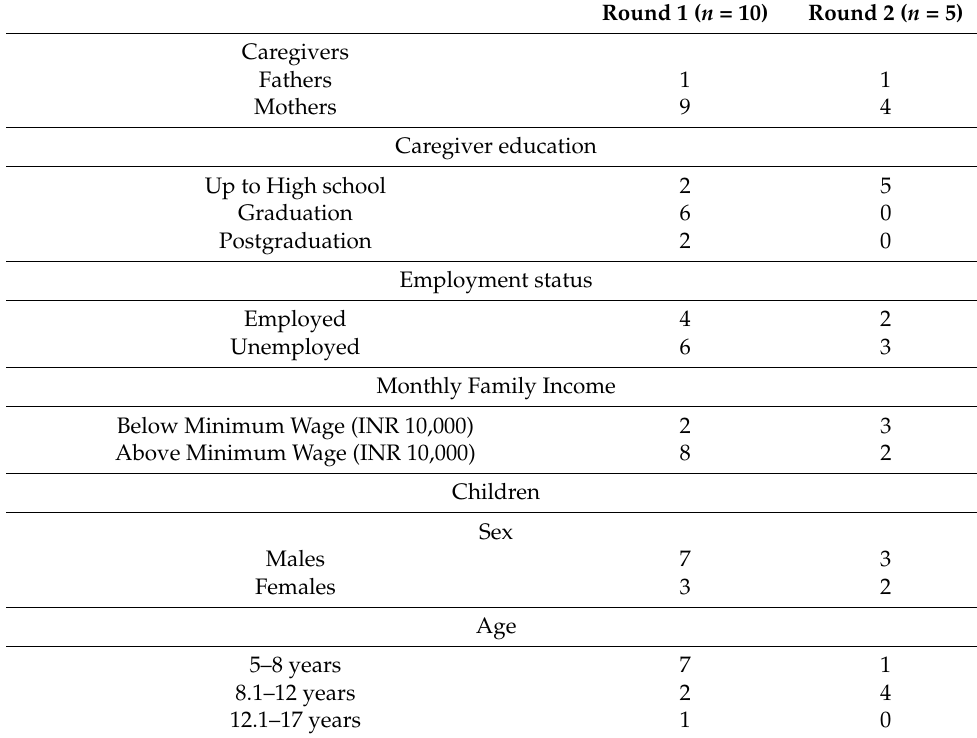
Table 2. Sociodemographic table of caregivers and children in Phase 1 ( n =